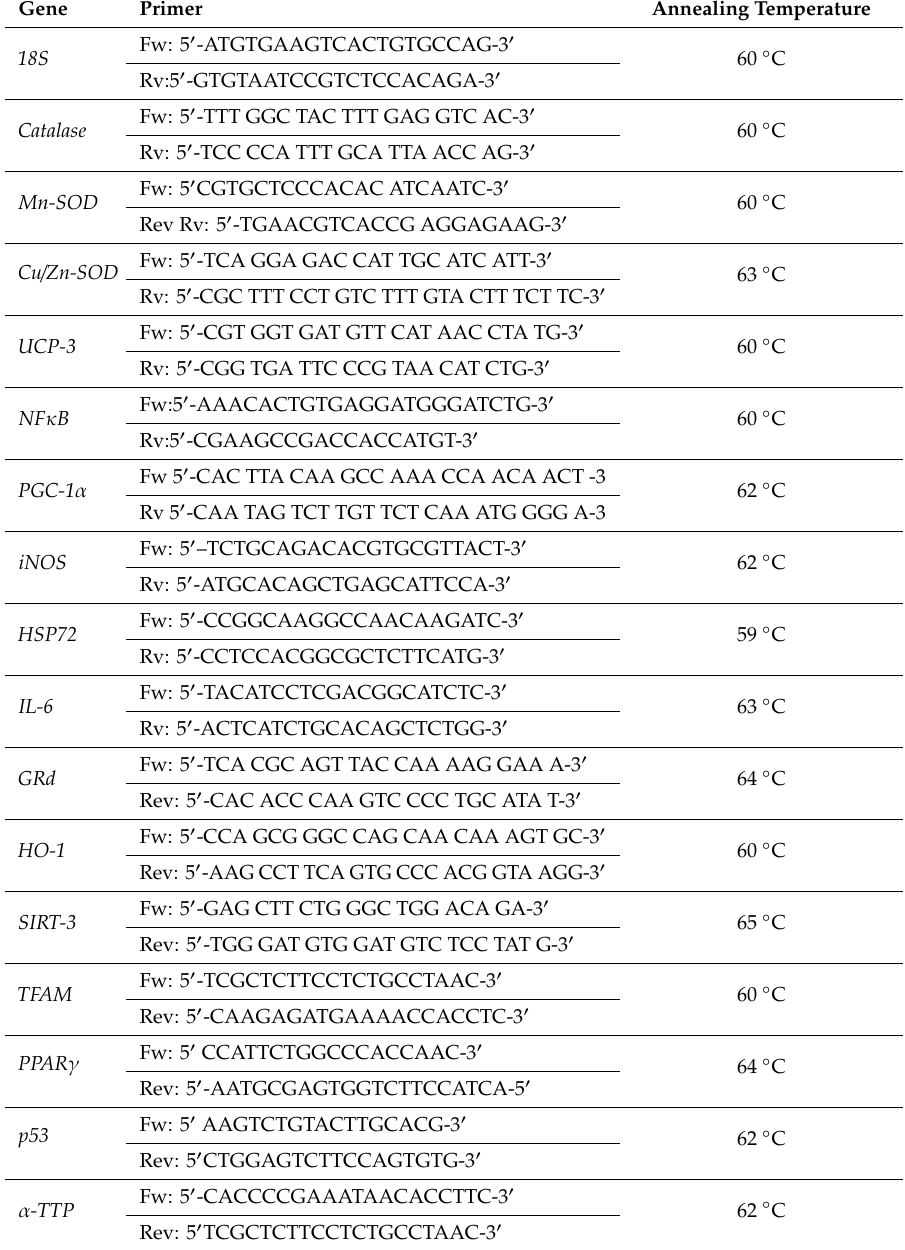
Table 2. Primers and conditions used in the real-time